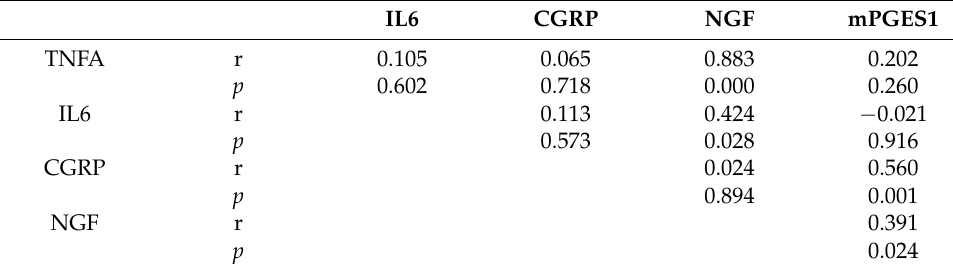
Table 4. Correlations among the expressions of various pain-related